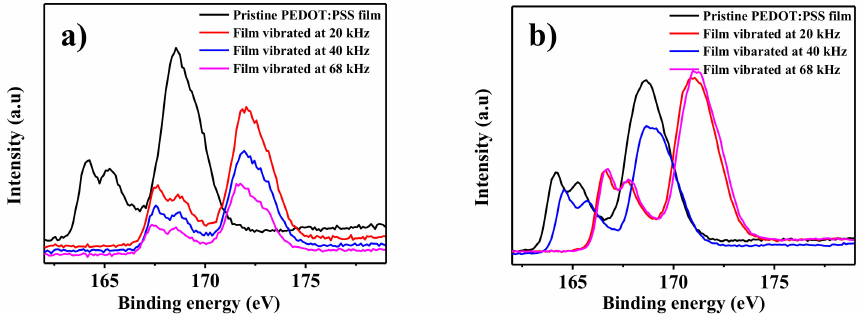
Figure 8. Sulphur 2p XPS spectra of the pristine and vibrated (SVPT) PEDOT:PSS coated on ( a ) glass/ITO, and ( b ) PET/ITO substrates. The vibration power is 5 W.